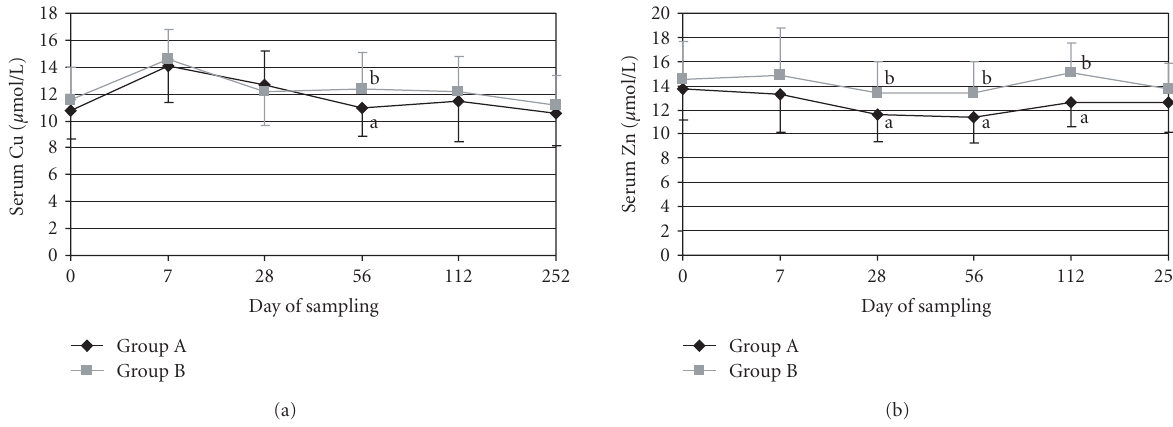
Figure 1: Copper (a) and zinc concentration (b) in blood serum ( μ mol/L) in the di ff erent feeding groups (Groups A and B); a < b, P < . 05.